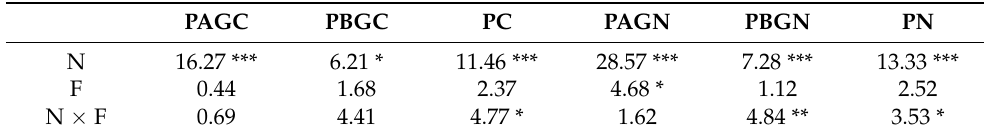
Figure 2. Effect of N addition levels and frequencies on the PAGC ( a ), PBGC ( b ), PC ( c ), PAGN ( d ), PBGN ( e ), and PN ( f ). Values are the means ± SE of four replications. F 2 and F 12 represent twice a year and once a month, respectively. Bars with different lowercase (a, b, c, d) and uppercase letters (A, B, C) are significantly different among N addition levels ( p < 0.05). “*” indicated significant differences between the F 2 and F 12 with the same N addition level ( p < 0.05). Table 1. Results (F values) of two-way ANOVA testing the effects of N addition levels (N) and frequencies (F) on the C and N pool of plant aboveground, plant belowground and plant community (PAGC, PBGC, PC, PAGN, PBGN and